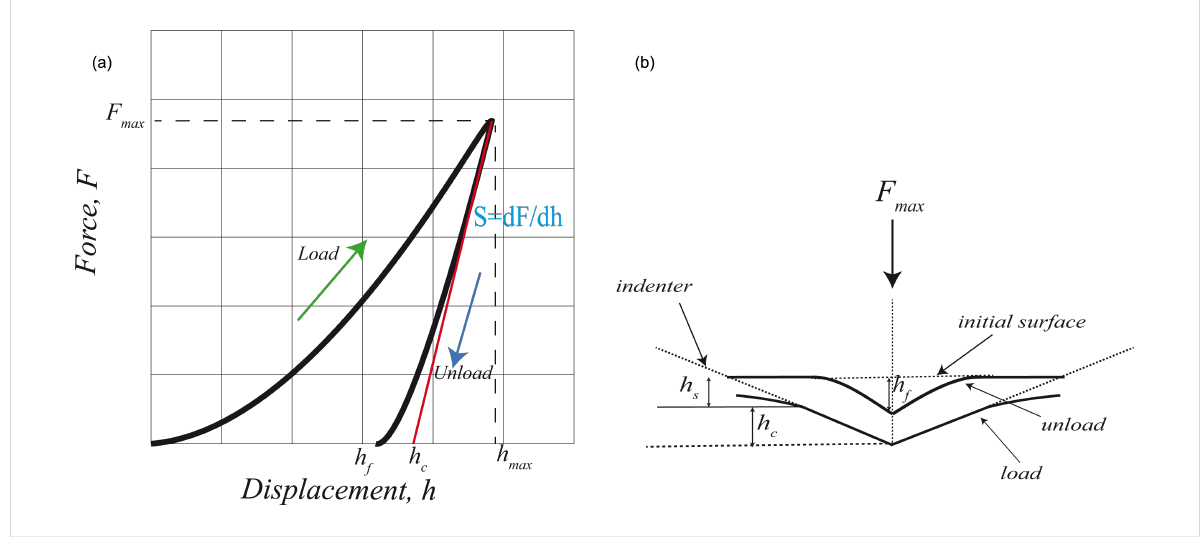
Figure 1: Schematic representation of the OP model. (a) A representative force–distance curve for the OP model; (b) Schematic illustrating loading and unloading